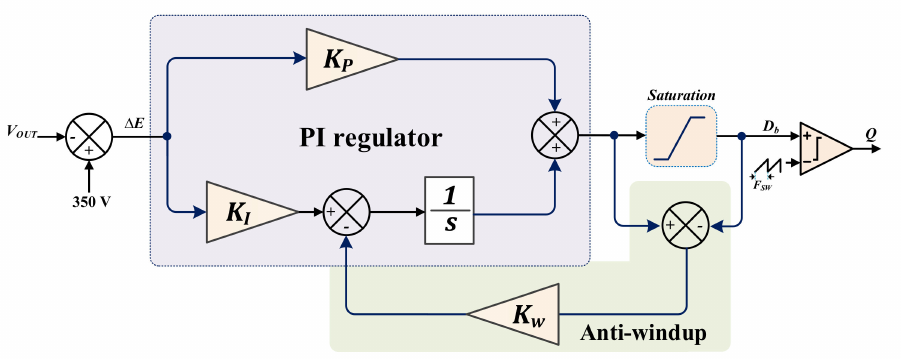
Figure 21. Block diagram of the closed-loop system using the PI regulator with an anti-windup strategy.